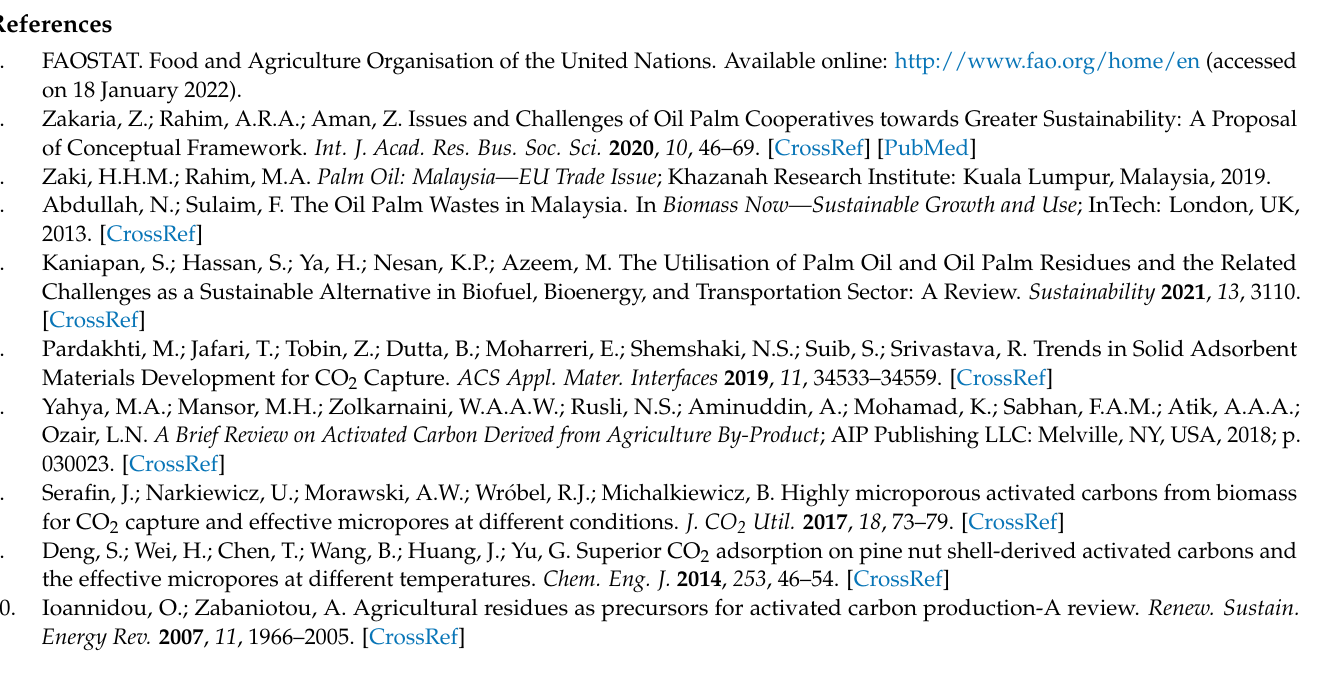
Figure A4. BET isotherm POR-C12.